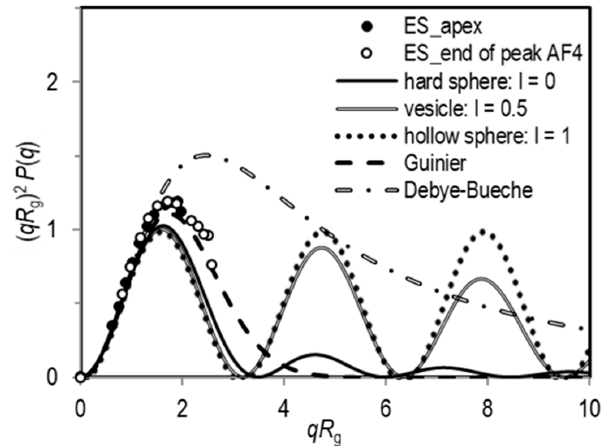
Figure 5. Kratky plots ( qR g ) 2 P ( q ) vs. qR g ) were constructed for large particles eluted at a peak apex (32 (32 min, full circles) and at ~35 min (open circles) in the AF4 / UV-MALS fractogram of the filtered min, full circles) and at ∼ 35 min (open circles) in the AF4/UV-MALS fractogram of the filtered exosome standard exosome standard (ES).